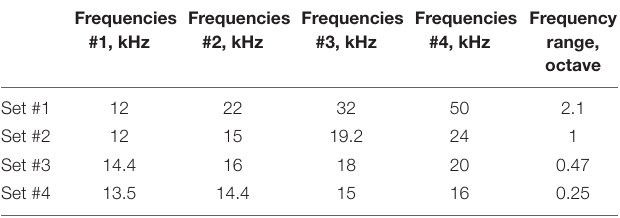
TABLE 1 | Test frequencies used in the experiments.